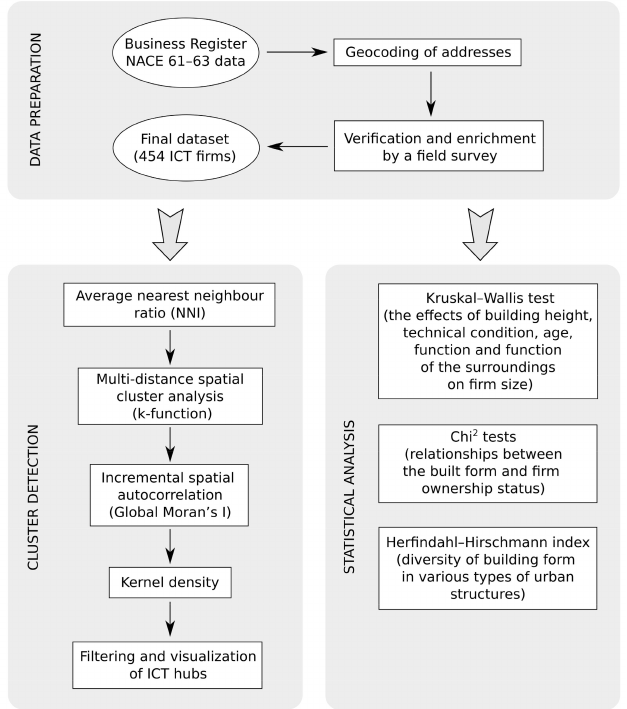
Figure 1. Methodology flow